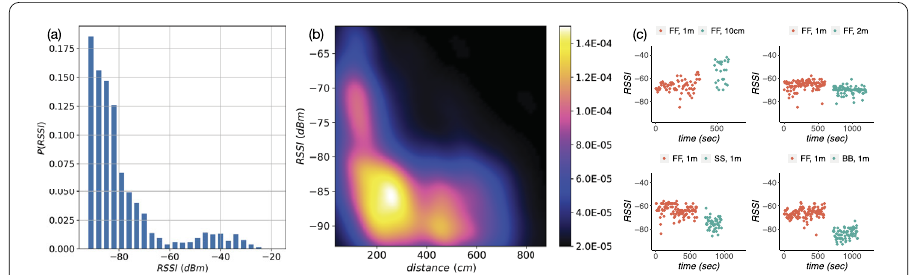
Figure 2 LPWD packet statistics. Panel ( a ) shows the distribution of RSSI values (bin-width = 3) observed by single badges over a week (24 hours, 196 badges); ( b ) Correlation between distance (x-axis) and RSSI (y-axis) values shown as a density plot (based on GT3 dataset); ( c ) Recorded RSSI values as a function of time in settings where the relative orientation of participants has been changed (based on GT2 dataset; position FF: face to face, SS: side by side, BB: back to back; distance: 10 cm, 1 m, 2